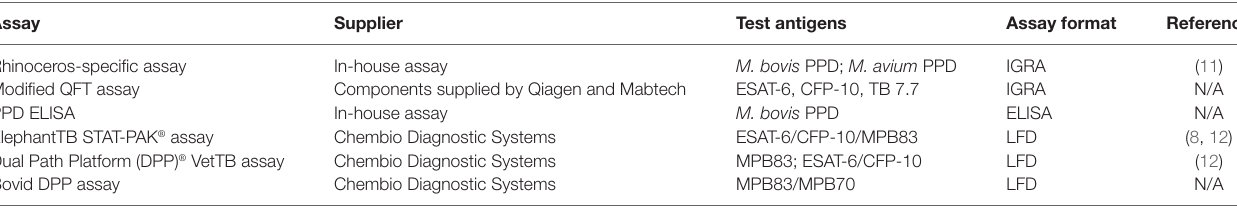
TaBle 1 | Immunoassays utilized to measure immune sensitization to selected antigens in Mycobacterium bovis -infected white rhinoceroses.